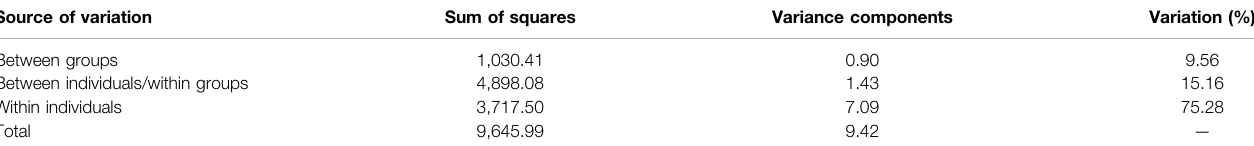
TABLE 10 | Results of the analysis of molecular variance for 19 herds of Curraleiro Pé-Duro based on microsatellite data. Source of variation Sum of squares Variance components Between